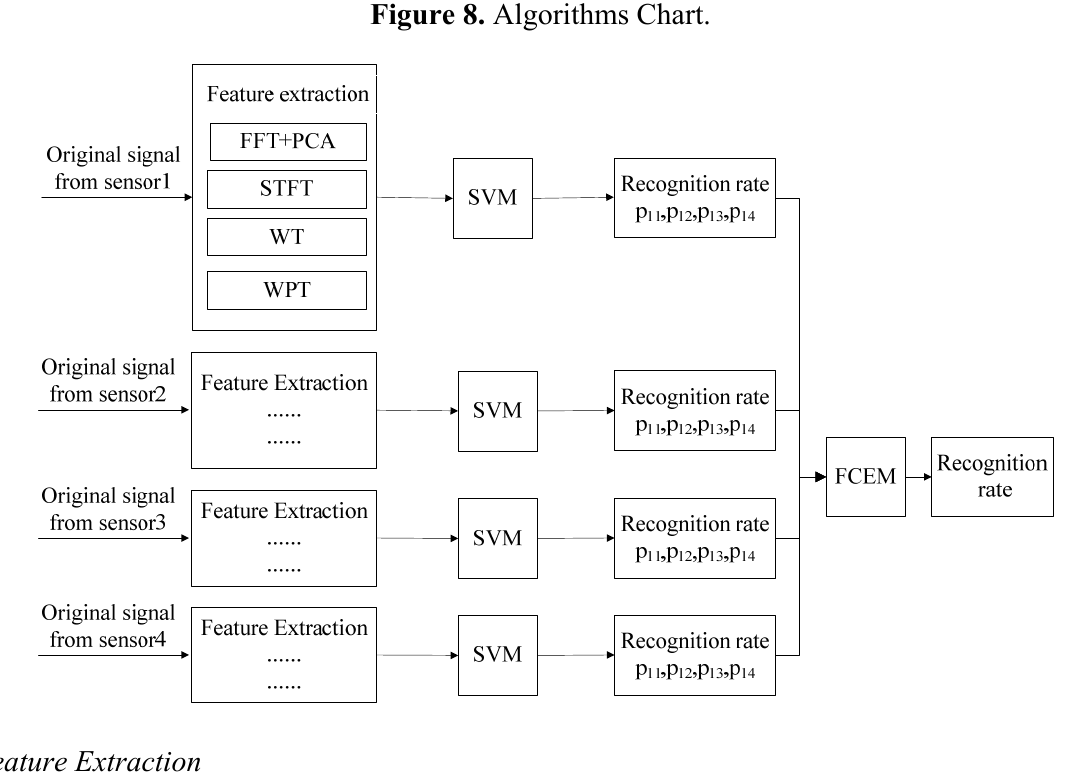
Figure 8. Algorithms